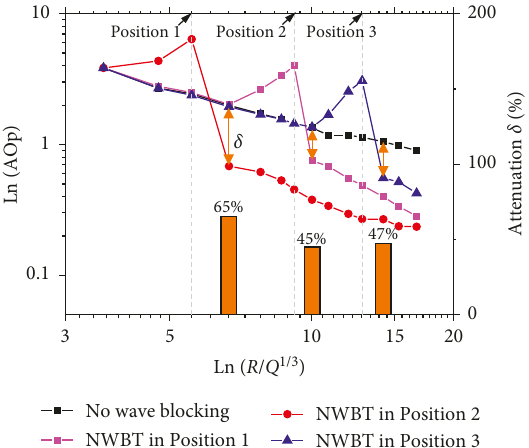
Figure 18: Blast wavefront near rigid wall and wave-blocking